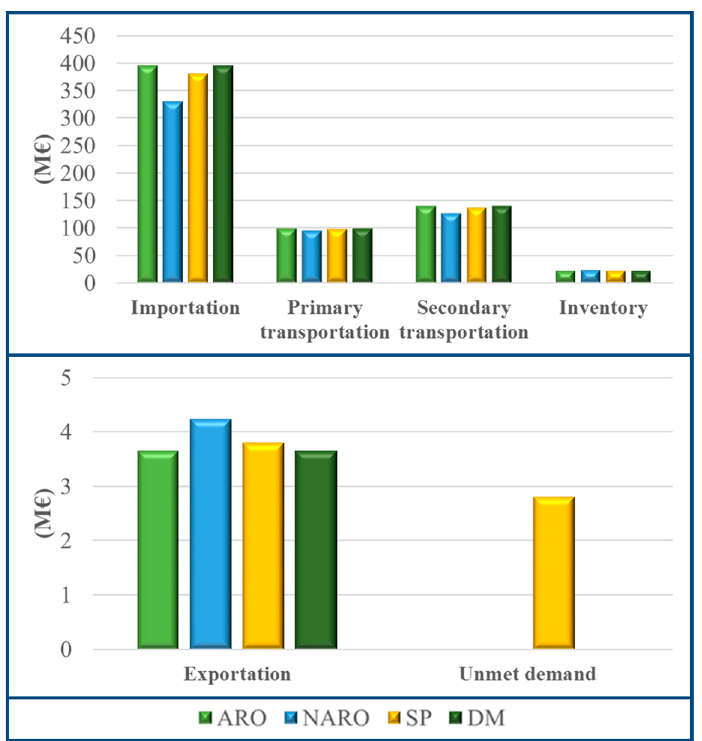
Figure 5. Cost items for the optimization models.